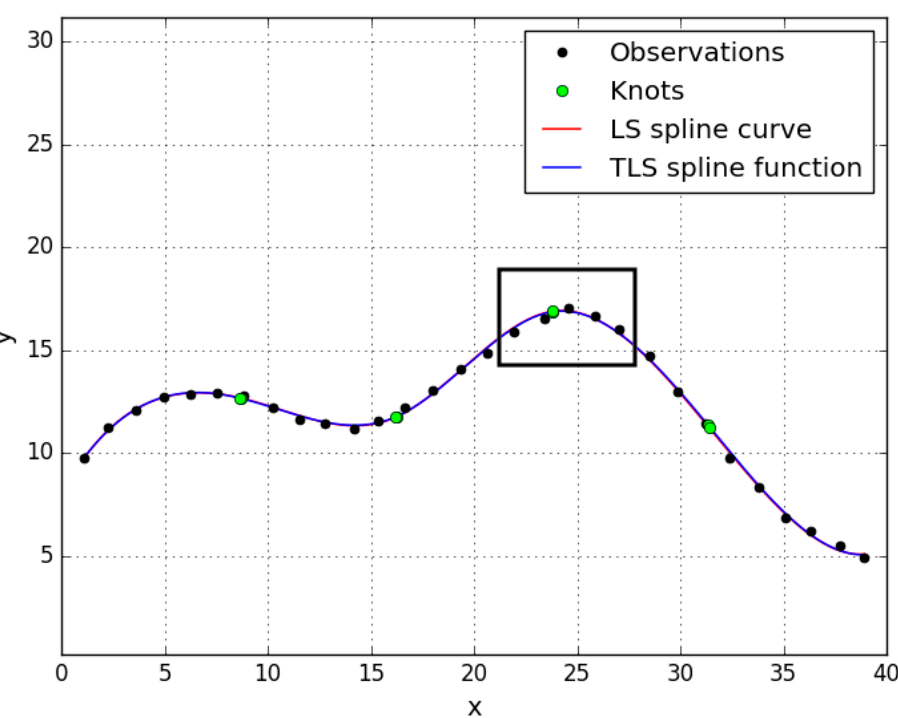
Figure 3. Total least squares (TLS) spline function and least squares (LS) spline curve with equally spaced location parameter.